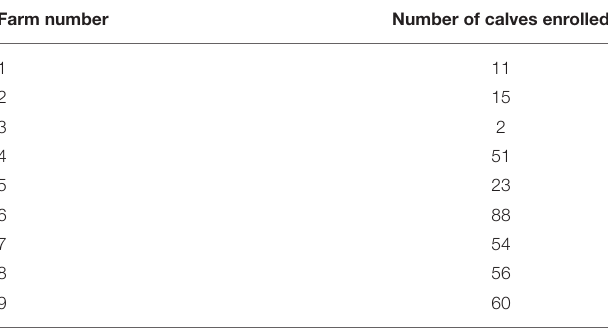
TABLE 1 | Number of calves enrolled from each farm.